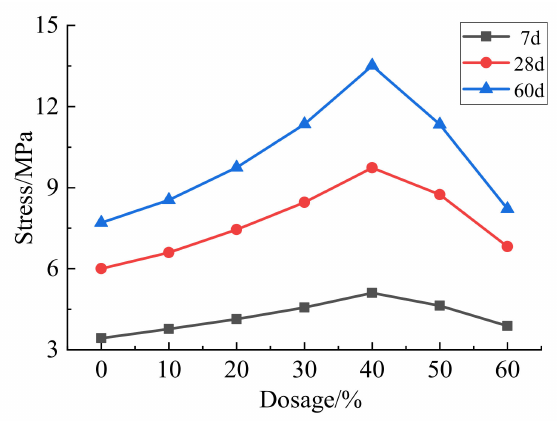
Figure 2. Relationship Curves of Peak Dynamic Stress and Admixture Ratio of Ni-Fe Slag Powder Soil Cement.